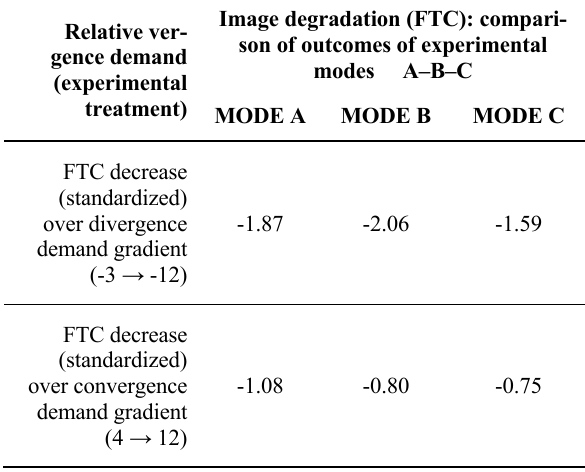
Table 4. Effect size of mode within divergence and convergence demand